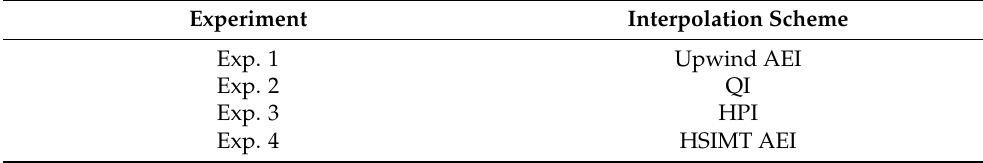
Table 1. Interpolation schemes in Exp.